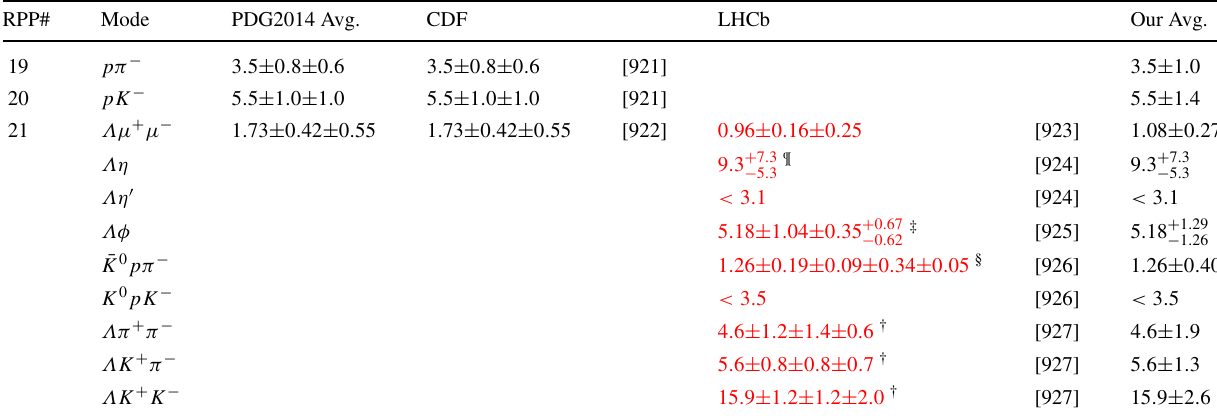
Table229 Branching fractions of charmless Λ 0 decays in units of × 10 − 6 . Upper limits are at 90% CL. Where values are shown in red (blue), b this indicates that they are new published (preliminary) results since PDG2014